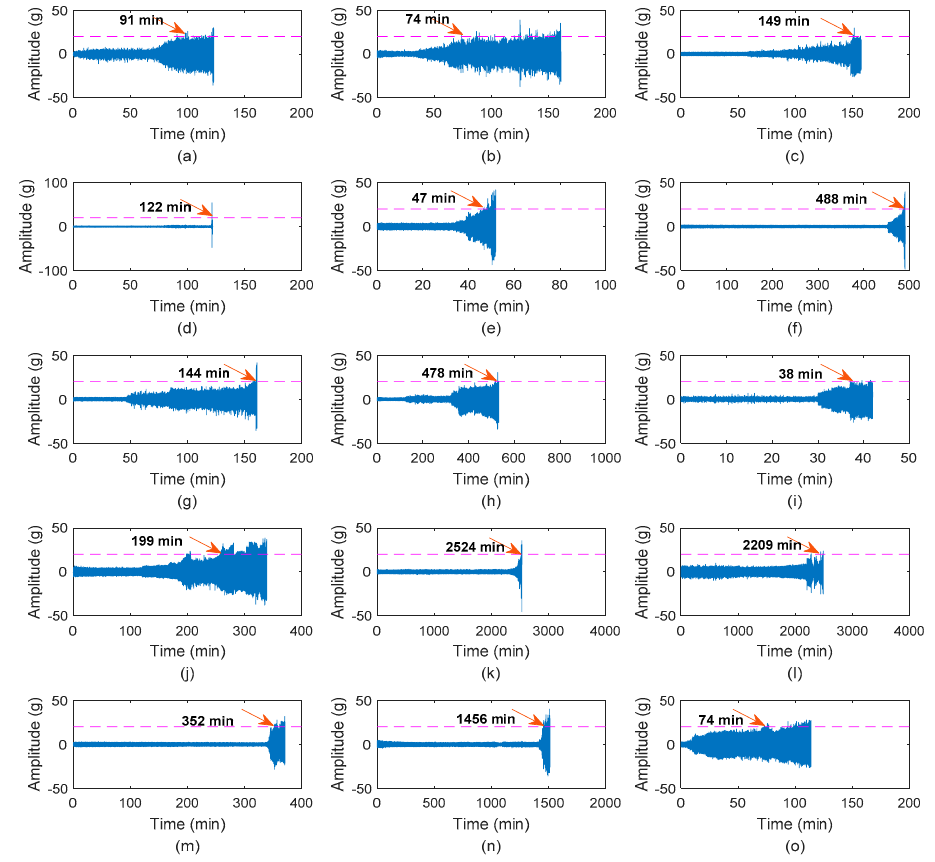
Figure 3. The selection of fault vibration signals. The ( a ) to ( o ) represent the vibration signals for the fifteen degradation experiments.